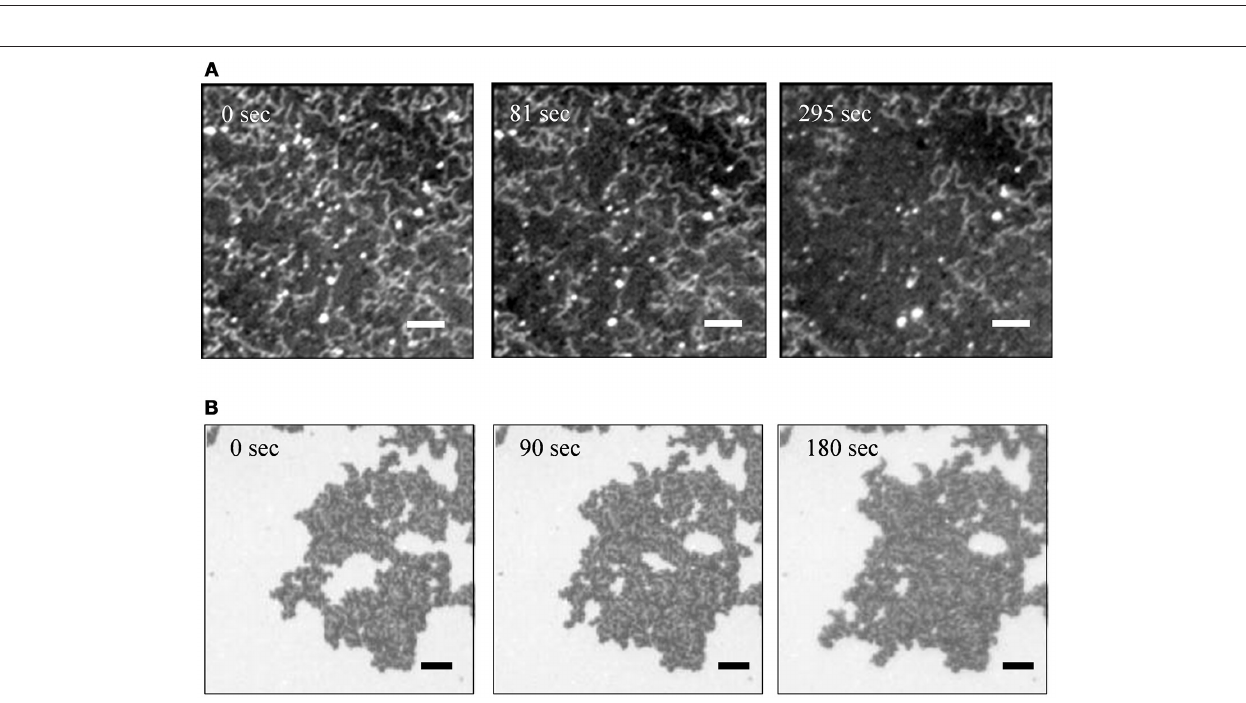
FIGURE 3 | AFM topographies and cross-section profiles of PLE-SLB with [Ca 2 + ] = 2.5mM obtained at different positions, [ (A) 2.0 µ m × 2.0 µ m, (B) 3.0 µ m × 3.0 µ m, (C) 2.0 µ m × 2.0 µ m] and the cross-section profile at the white line in each AFM topography.